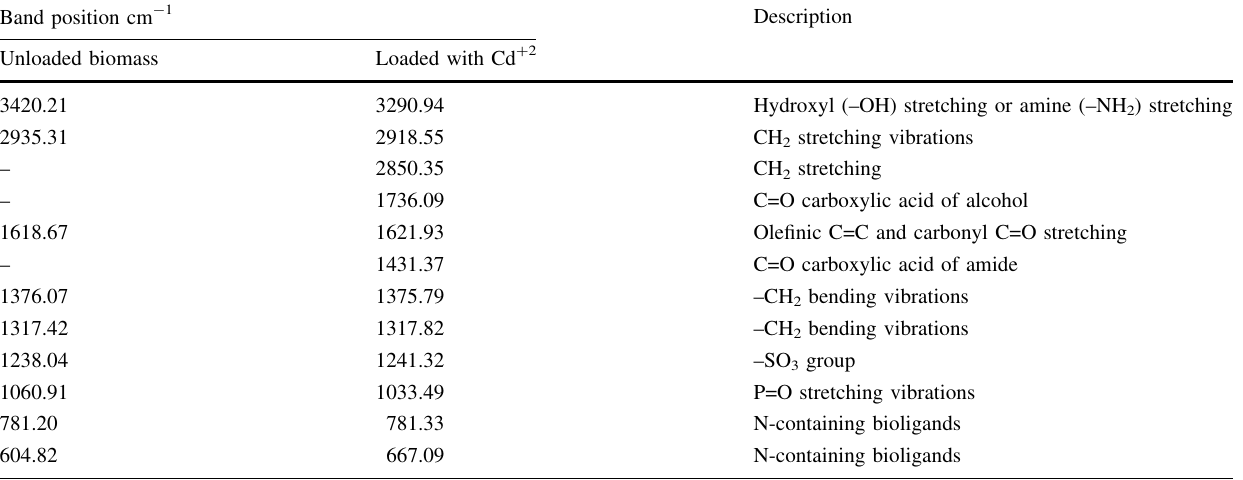
Table 5 Band positions of A. heterophylla unloaded and loaded with Cd(II) Band position cm -